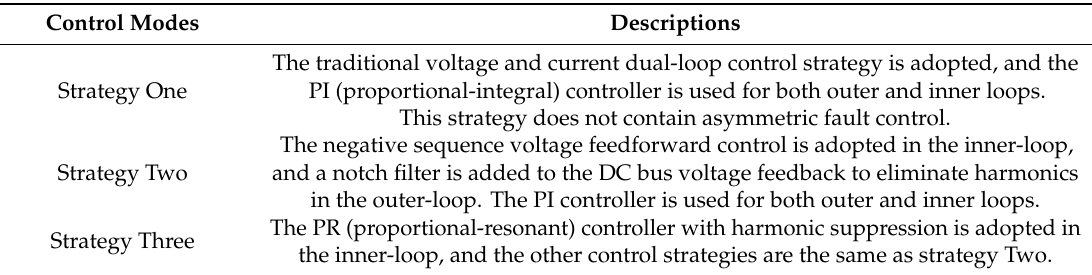
Table 6. The control modes for simulation